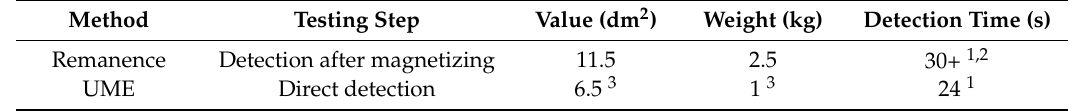
Table 1. Comparison of the remanence device with UME.